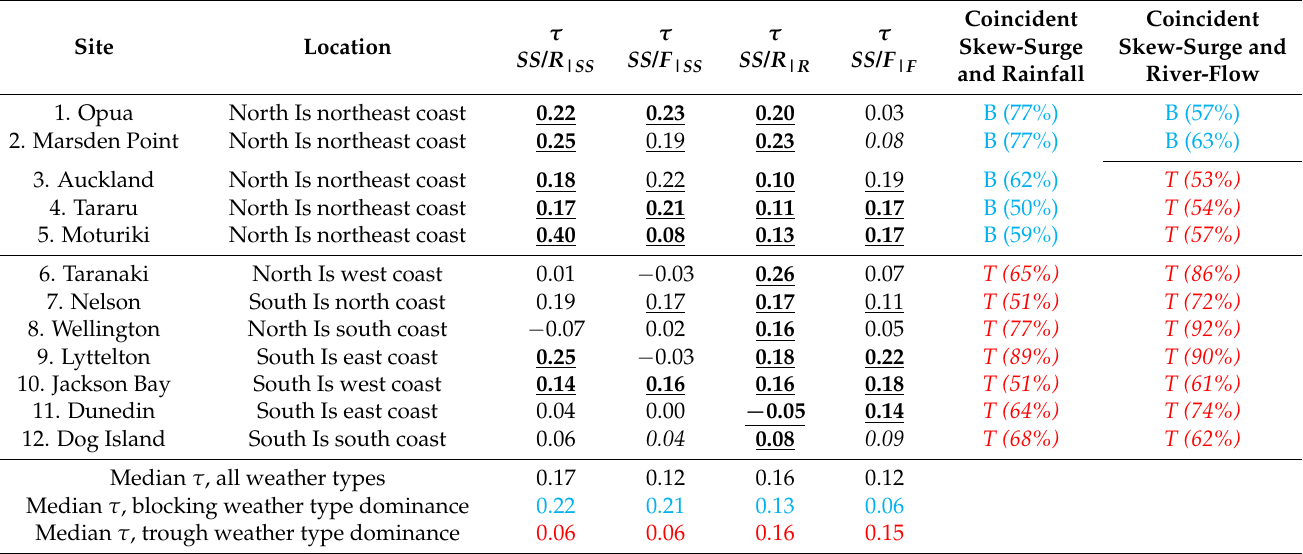
Table 2. Spatially-averaged Kendall’s τ for the four dependence cases analyzed using ± 1-day lag (Table 1, Figure 4) at each sea-level recorder location, and dominant weather types. Kendall’s τ : bold underlined = significant at p -value ≤ 0.05 using rainfall or river-flow records within 30 km radius of sea-level gauge; underlined not bold = significant at p -value ≤ 0.05 using river-flow records within 100 km radius; normal font = insignificant ( p -value > 0.05); italics = insignificant ( p -value > 0.05) and using river-flow records within 100 km. B = dominance of blocking weather type (including percentage of coincident events during blocking weather types), and T = dominance of trough weather type (including percentage of coincident events during trough weather